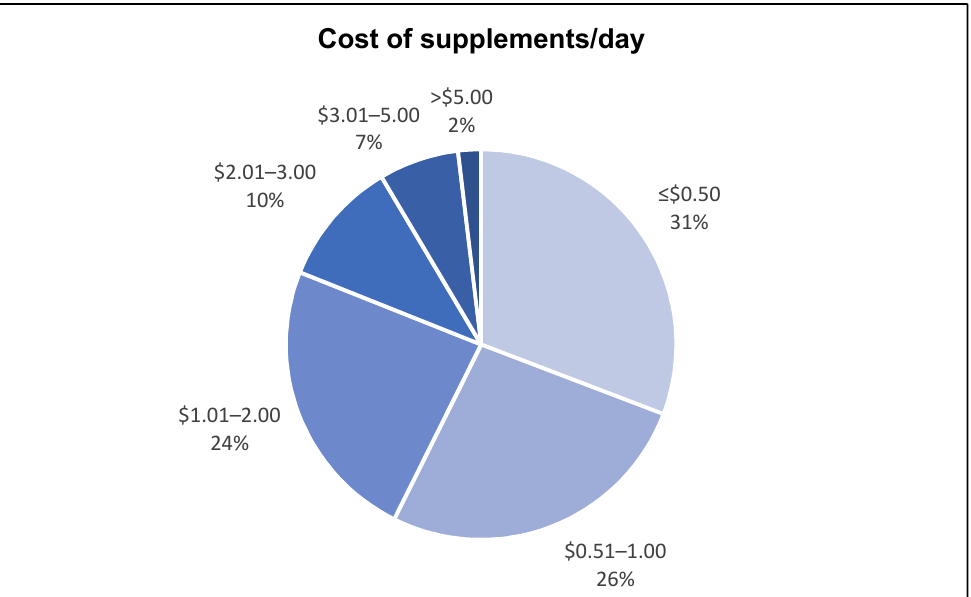
Figure 4. Distribution of supplement cost per day.